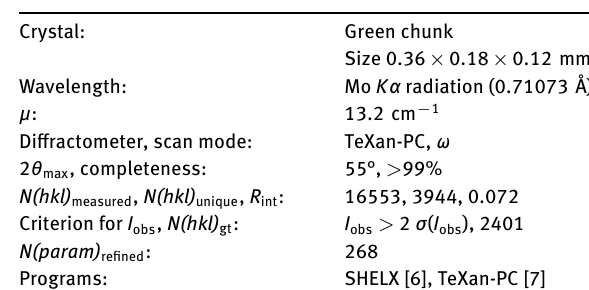
Table 1: Data collection and handling.